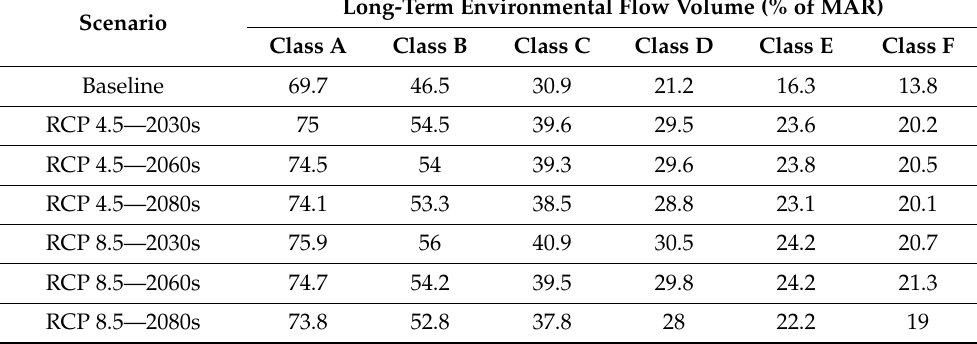
Table 7. Estimate of long-term EF volume of the Babai River at the Chepang Station for different EMC classes and scenarios.